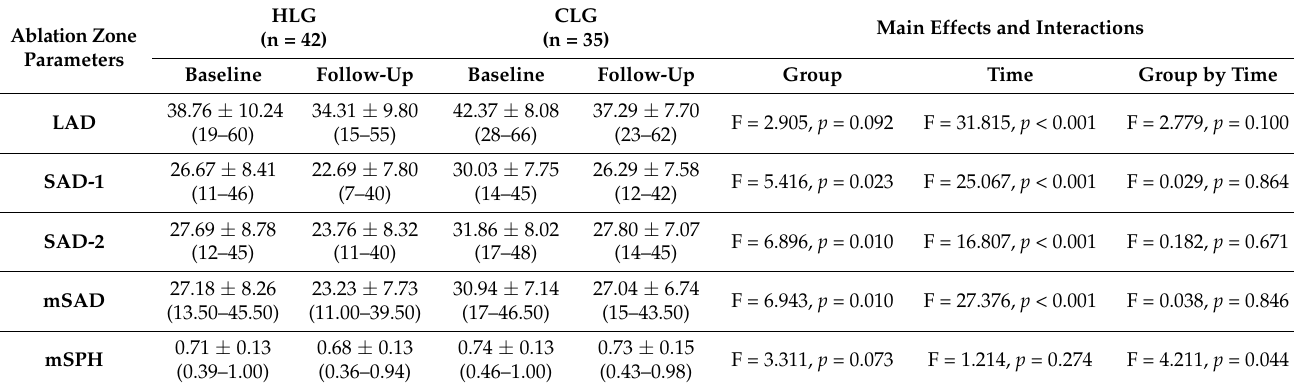
Table 2. Ablation zone diameter (in mm) and sphericity index for HLG and